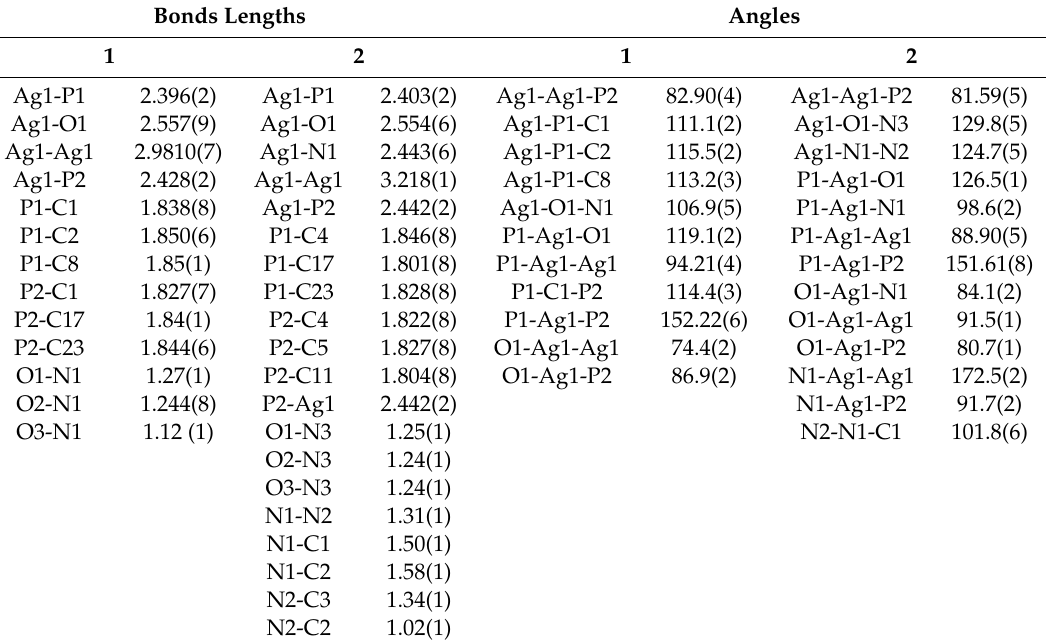
Table 2. Selected geometric parameters (bond lengths in Å, angles in degrees) for complexes 1 and 2a . Bonds Lengths